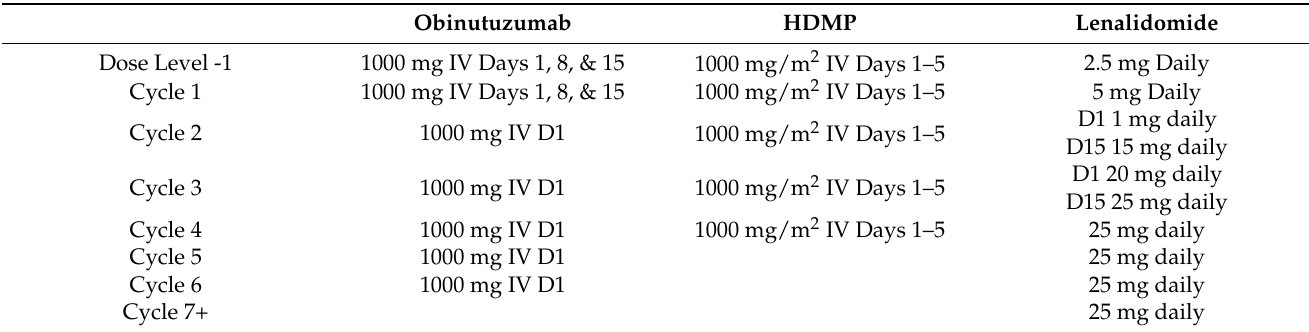
Table 1. Treatment